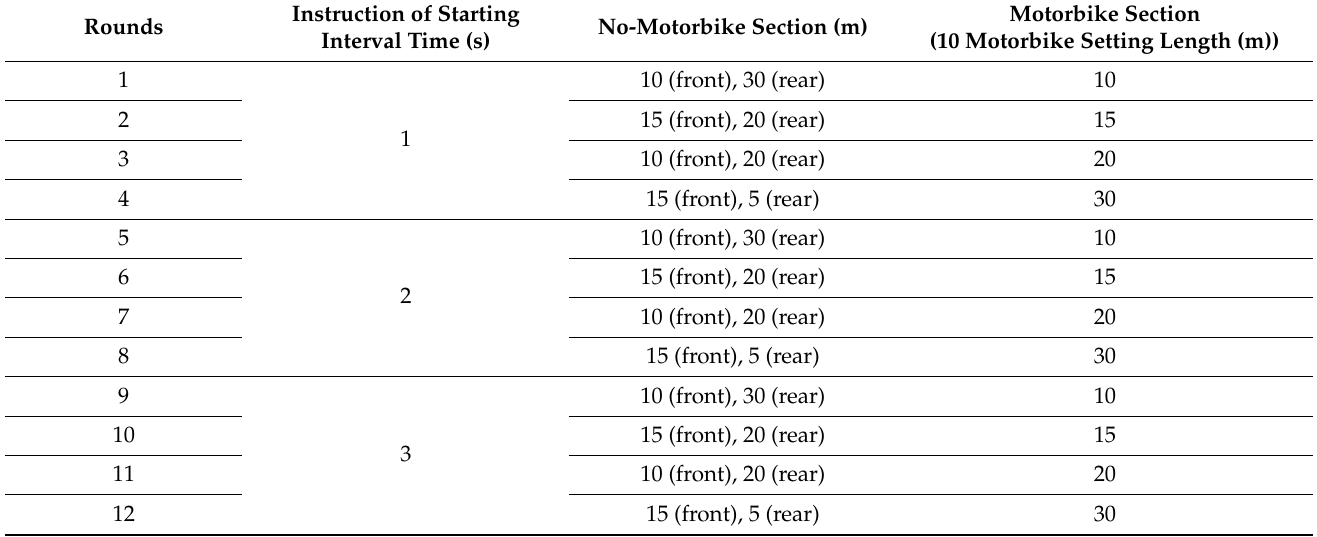
Table 7. Experimental